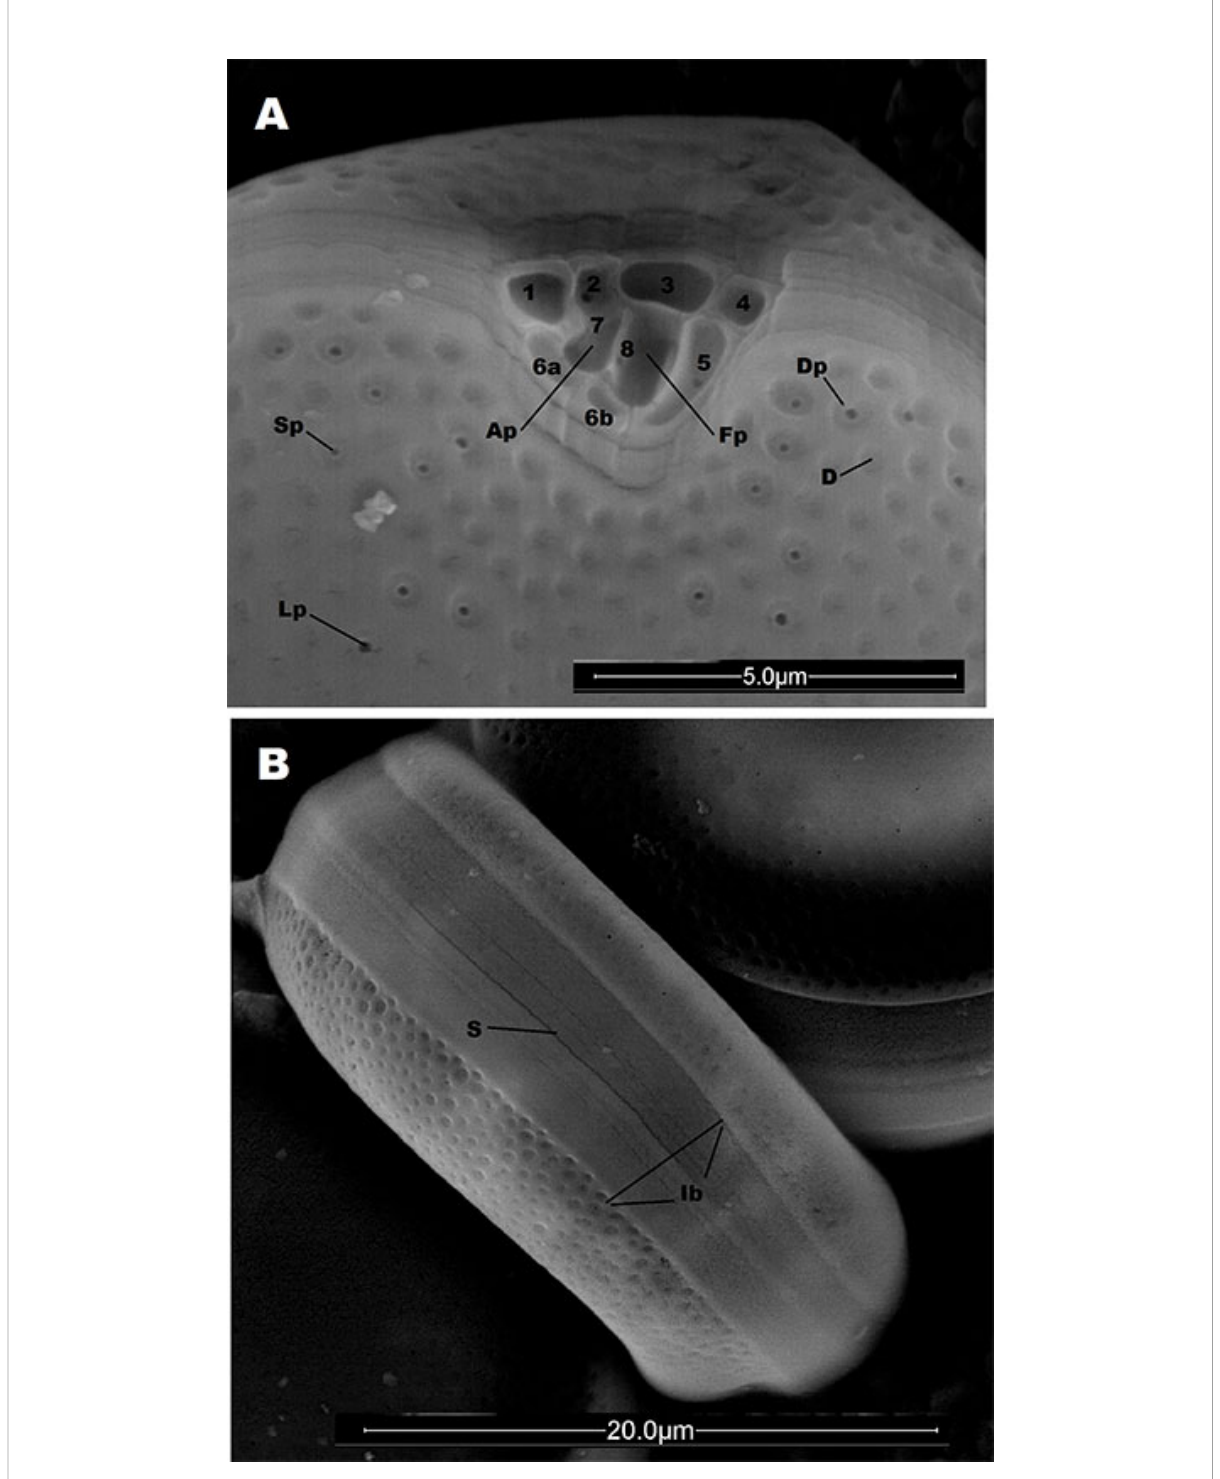
FIGURE 3 Prorocentrum borbonicum : scanning electron micrographs (A, B) . (A) View of the peri fl agellar area and part of the right thecal plate, showing: Ap, small accessory pore; Fp, large fl agellar pore; D, Depressions; Sp, small thecal pores; Lp, large thecal pore; Dp, depression with pore; and nine platelets of the peri fl agellar area (1, 2, 3, 4, 5, 6a, 6b, 7 and 8). (B) Theca in antapical view showing: S, suture; Ib, Intercalary